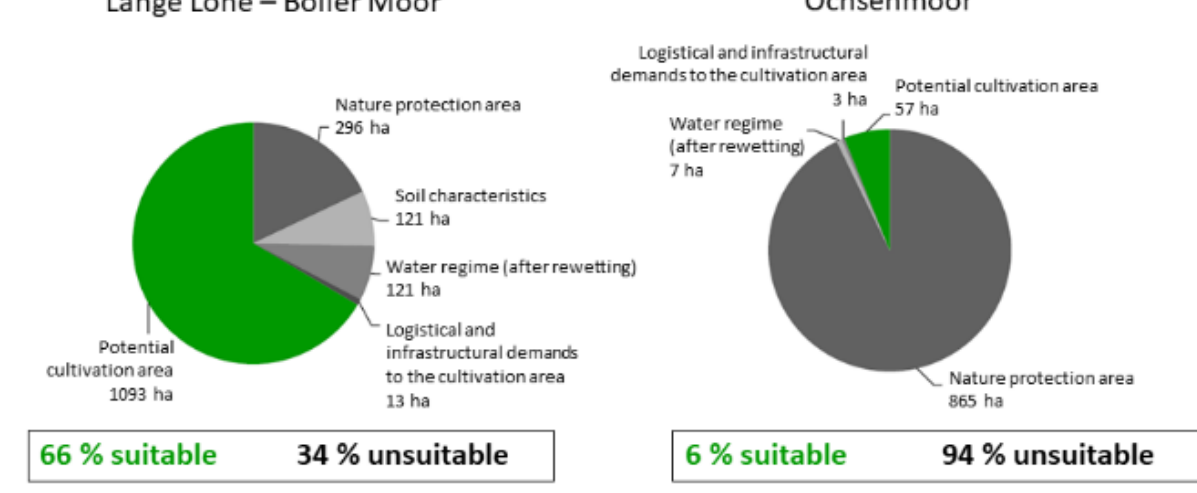
Figure 5. Elimination of potential cultivation area by criteria, and maximum remaining cultivation potential for reed, in the study areas “Lange Lohe - Boller Moor” (LL; n = 1644 ha) and “Ochsenmoor” (OM; n = 933